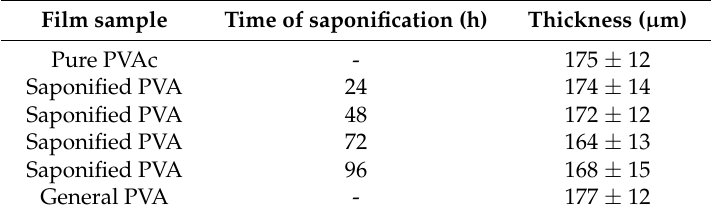
Table 1. Thicknesses of the PVAc film, general PVA film, and saponified PVA film at different time intervals. Film sample Time of saponification (h) Thickness ( µ